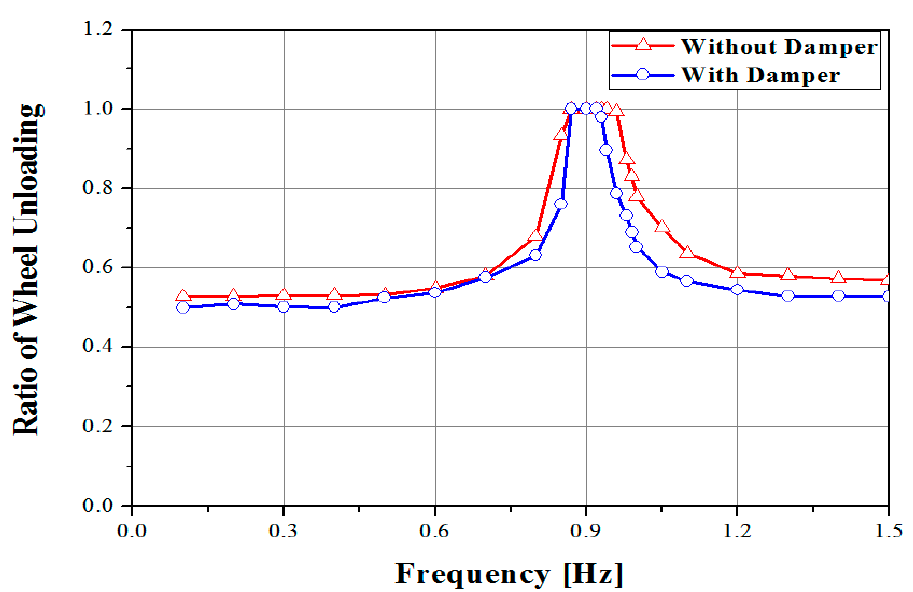
Figure 15. The comparison of the ratios of wheel unloading between the models with dampers and without dampers (simulation results).